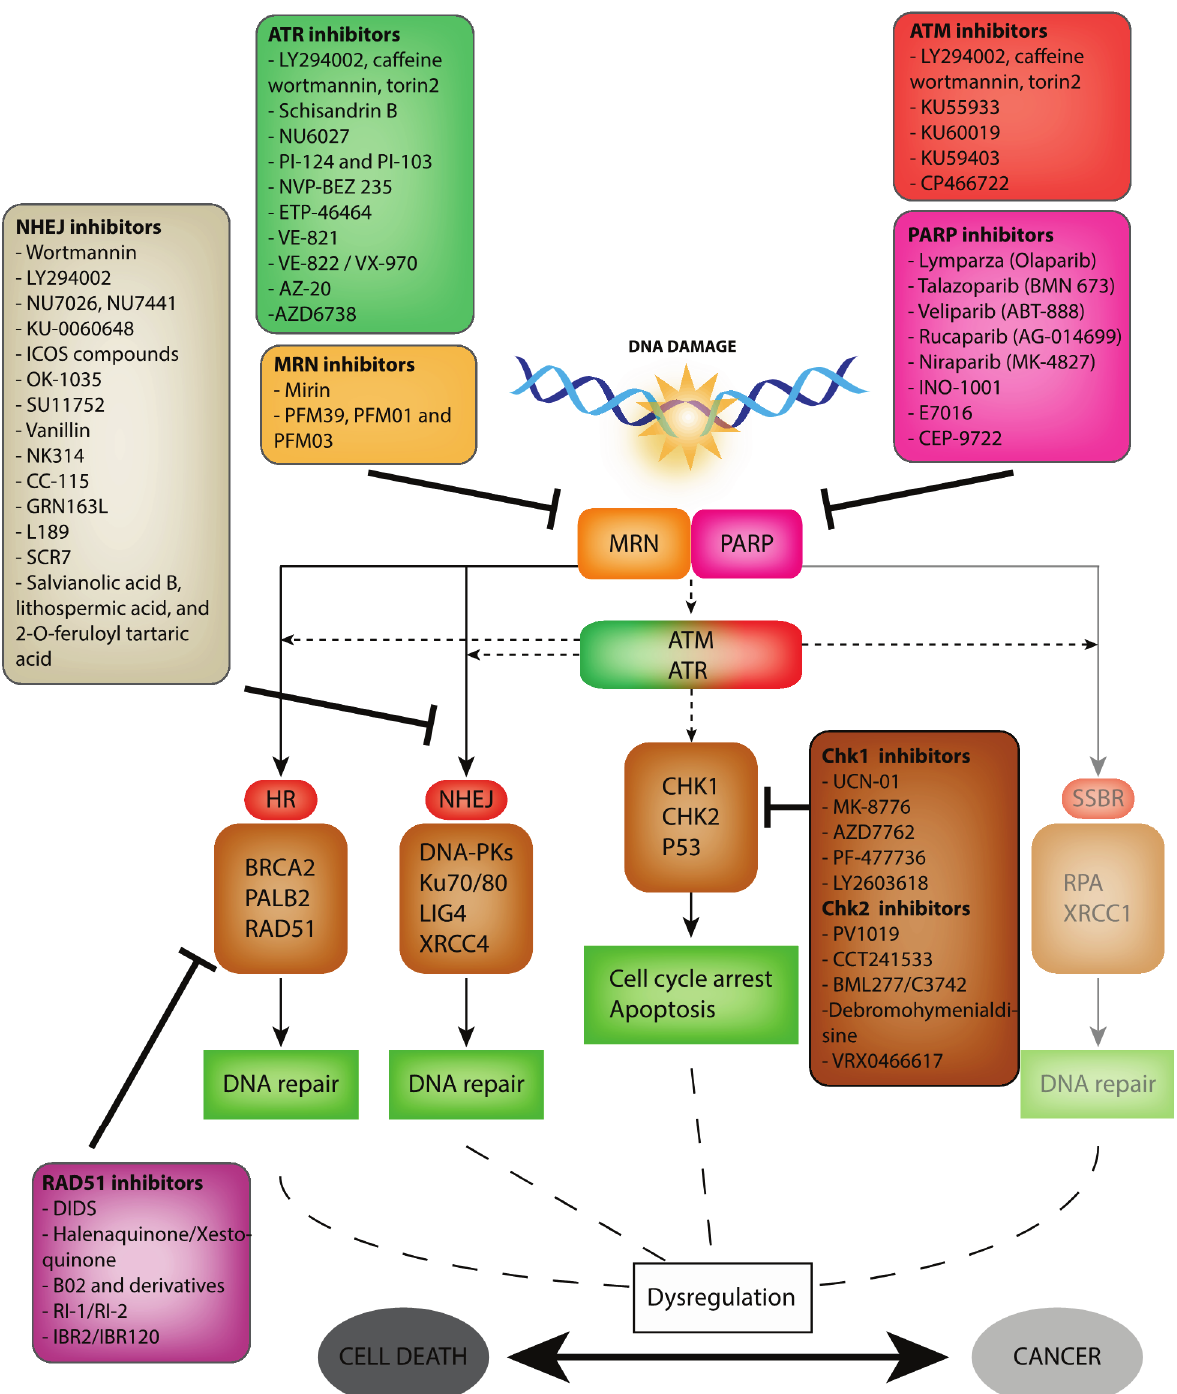
Figure 1. The DNA damage response pathways and its